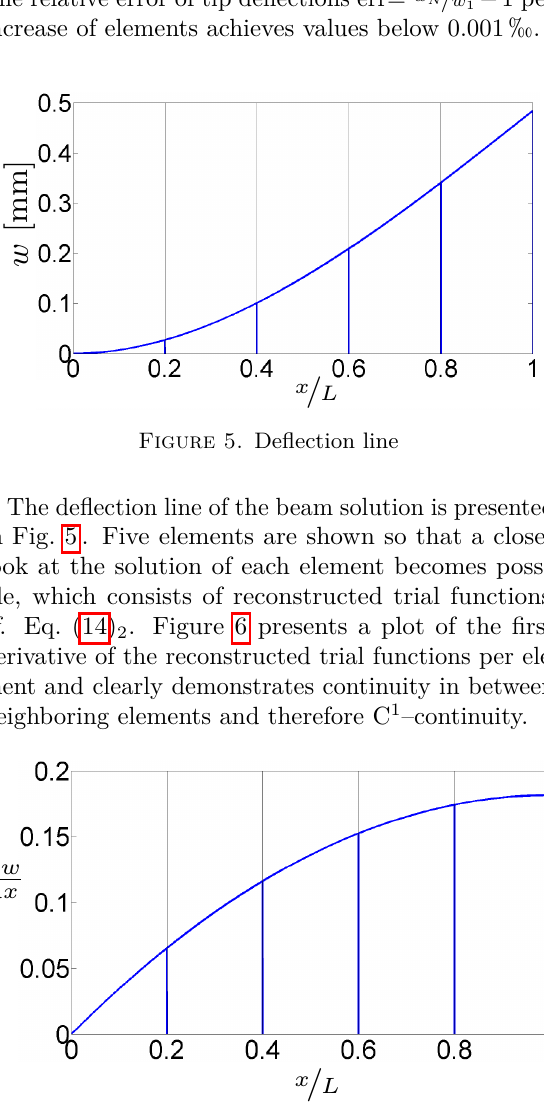
Figure 4. Convergence Figure 7. Second derivative of the solution Table: Dimensions, loads and material parameters